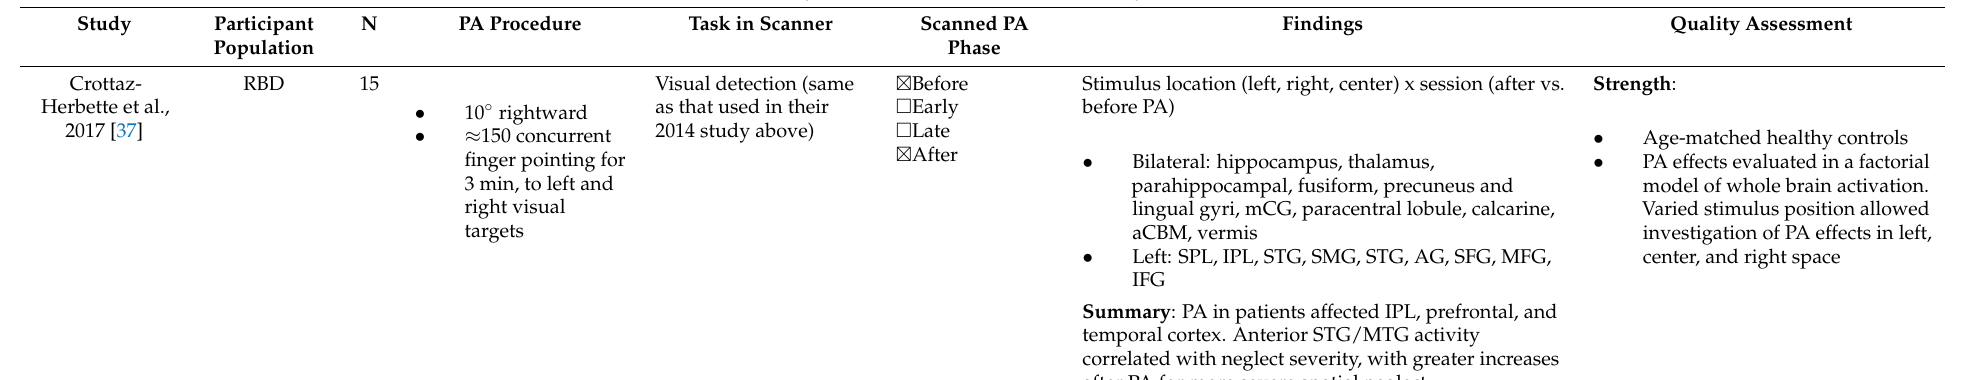
Meta-Analysis 1: Before and after PA in Healthy